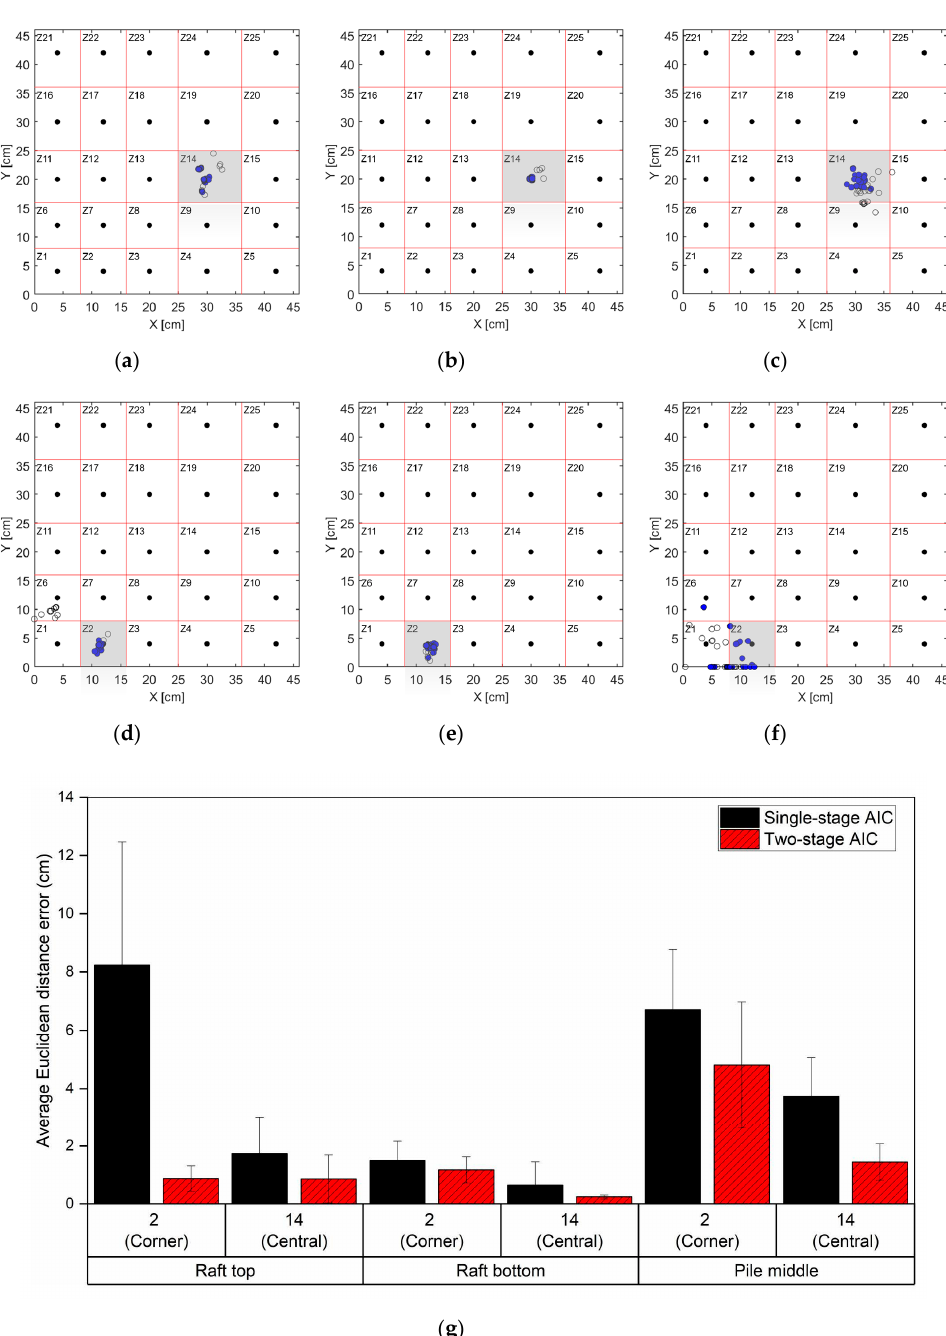
Figure 9. Localized sources estimated using the two-stage AIC method when the hit sources were on a central and a corner region of the sensor network. Hits were applied on the raft top of Zone #14 ( a ) and #2 ( d ), under the raft bottom of Zone #14 ( b ) and #2 ( e ), and in the middle of Zone #14 ( c ) and #2 ( f ). The blue filled dot shows the result of two-stage AIC and the hollow gray dot shows the result of single-stage AIC. ( g ) The average Euclidian distance errors estimated from the single-stage and two-stage AIC